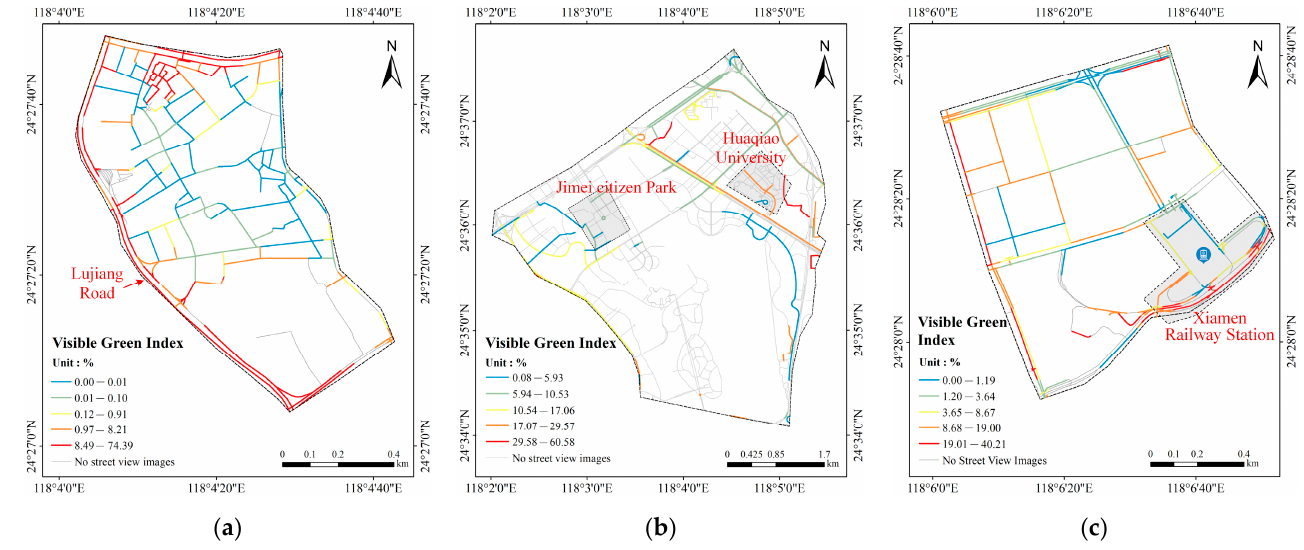
Figure 6. Visualisation results of the visible green indicator in ( a ) Area Ⅰ , ( b ) Area Ⅱ , and ( c ) Area Ⅲ .